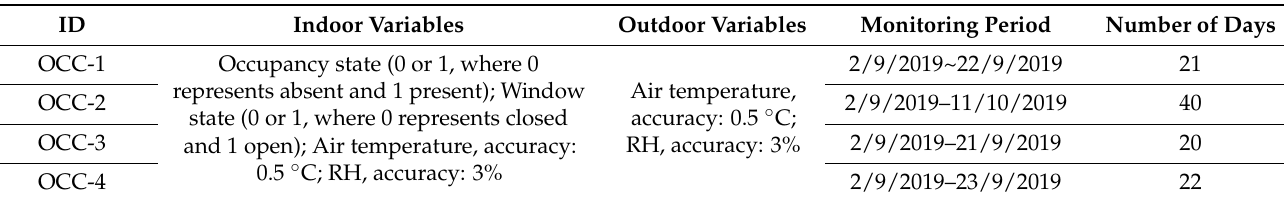
Table 1. Variables and